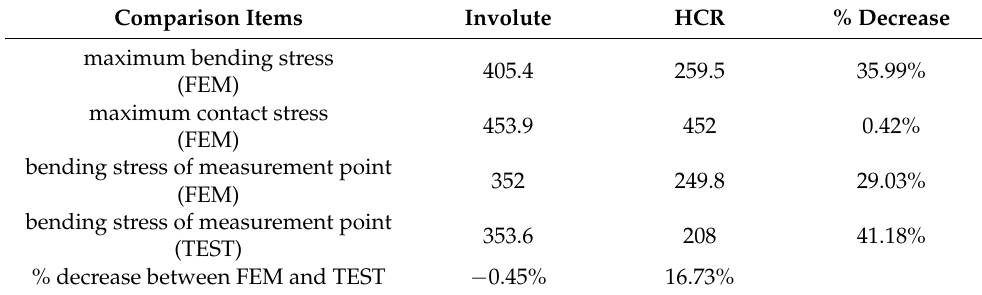
Figure 21. Comparison of bending and contact stress between involute and HCR internal gear pairs. Table 4. Percentage decrease of stress between involute and HCR internal gear